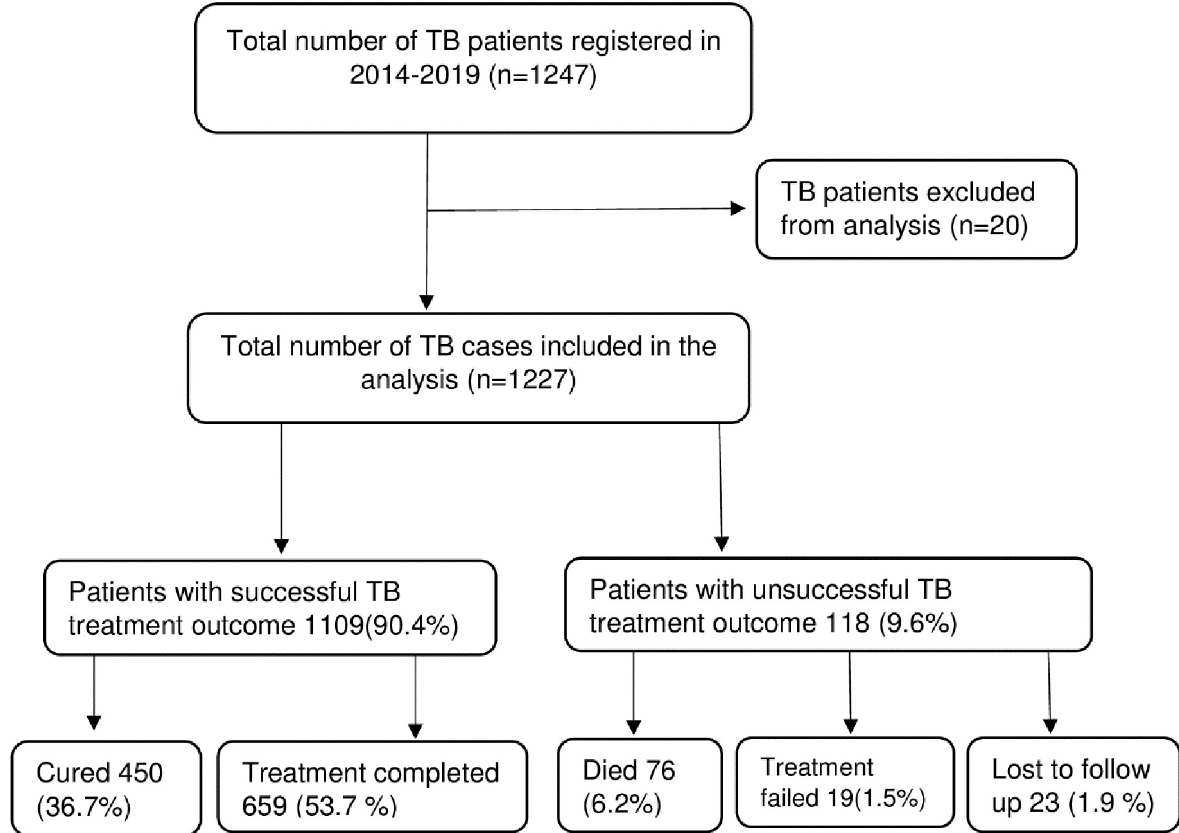
Fig 1. Consort chart showing cases selection for analysis and their TB treatment outcome in Northern Red Sea region, 2014–2019 cohort (n = 1227). https://doi.org/10.1371/journal.pone.0273069.g001 PLOS ONE | https://doi.org/10.1371/journal.pone.0273069 August 15,